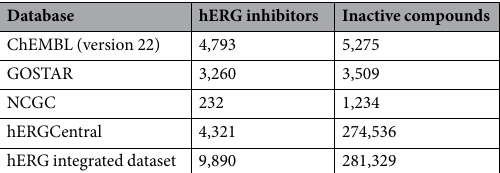
Table 1. Details of the integrated dataset.